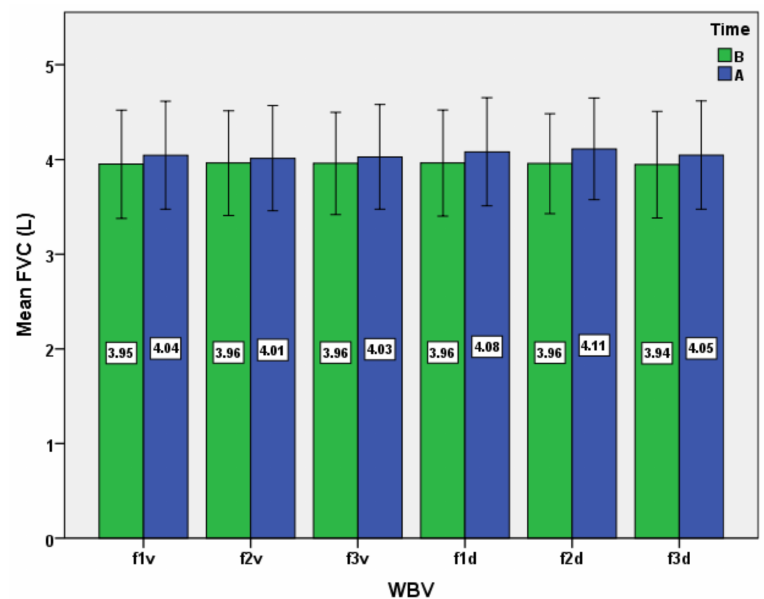
Figure 4. Impact of the WBV exposure on forced vital capacity (FVC) for the six protocols (means and standard deviations). B, before; A, after.